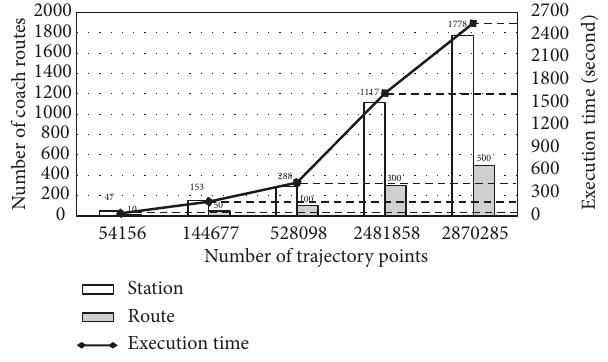
Figure 11: Efficiency analysis of